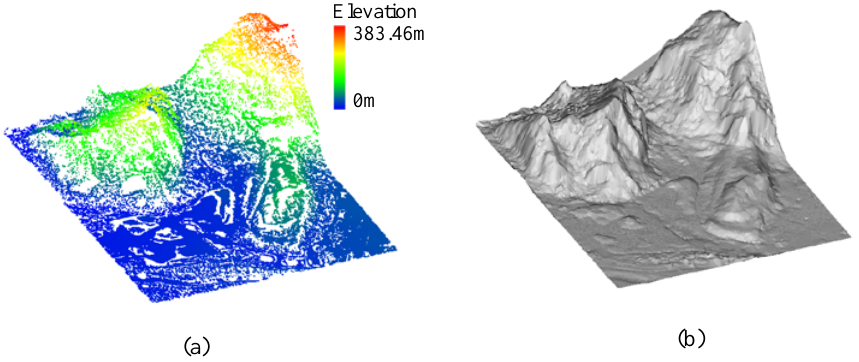
Figure 8. Construction result of initial provisional DTM. ( a ) Ground seed points, ( b ) initial provisional DTM.